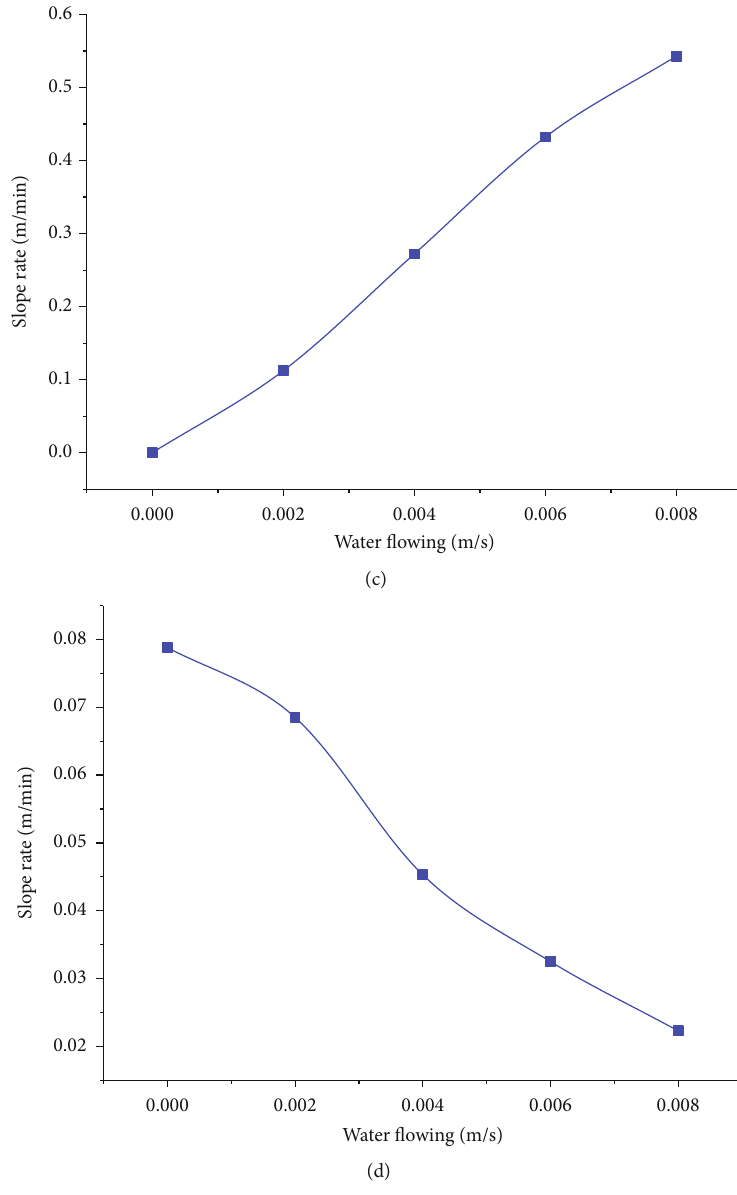
Figure 13: Slurry di ff usion characteristics under di ff erent fl ow conditions. (a) Slurry di ff usion in downstream with time. (b) Slurry di ff usion in side boundary. (c) Slope rate in downstream with water fl owing. (d) Slope rate in upstream with water fl